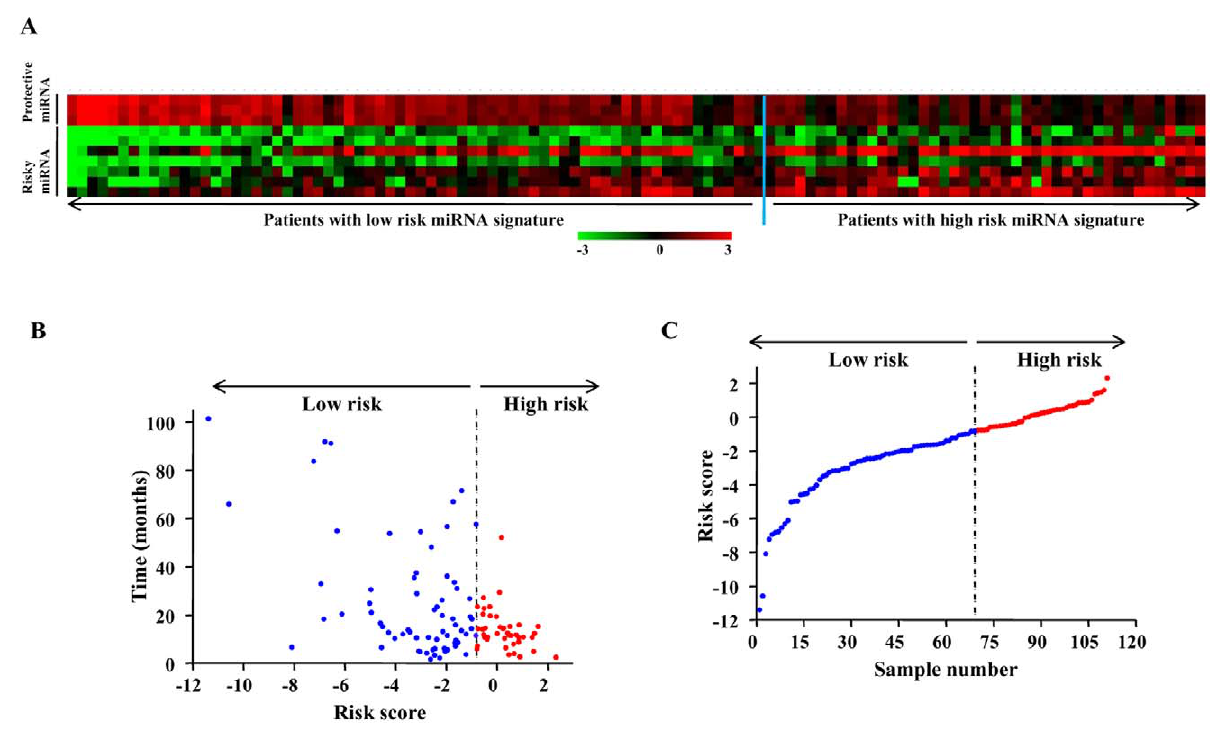
Figure 2. Ten miRNA Risk-Score Analysis of 111 GBM patients (training set). A ) Heat map of ten miRNA expression profiles of GBM patients; rows represent risky and protective miRNAs, and columns represent patients. The blue line represents the miRNA signature cutoff dividing patients into low-risk and high-risk groups. B ) Patient survival status along with risk score. C ) miRNA risk-score distribution of the GBM patients.